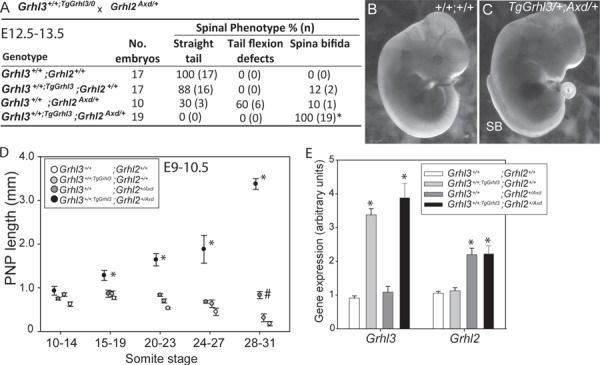
Genetic interaction between Grhl2 and Grhl3 overexpressing alleles results in severe SB. (A–C) Among experimental litters generated by intercross of Grhl2Axd/+ and Grhl3+/+:TgGrhl3/0 mice, all compound heterozygous fetuses exhibited severe SB. Note the very large size of the SB lesion that extends as far rostrally as the forelimb bud at E13.5 (C) (*P < 0.001; significant difference among genotypes, Chi-square). (D) Analysis of PNP length among embryos at E9–10.5 shows that compound heterozygous, Grhl2Axd/+;Grhl3+/+:TgGrhl3/0 embryos have significantly enlarged PNPs from E9.5 (15–19 somite stage) onwards (*, significant difference from all other genotypes, P < 0.001). At E10.5 (28–31 somites) the PNP length of Grhl2Axd/+;Grhl3+/+;TgGrhl3/0 embryos is also greater than in wild type (#, P < 0.01). (E) In the caudal region of E9.5 embryos, mRNA abundance of Grhl2 and Grhl3 corresponds with the presence of the Grhl2Axd and Grhl3TgGrhl3 alleles, with no indication of reciprocal regulation (*, differences from wild-type expression level, P < 0.01).